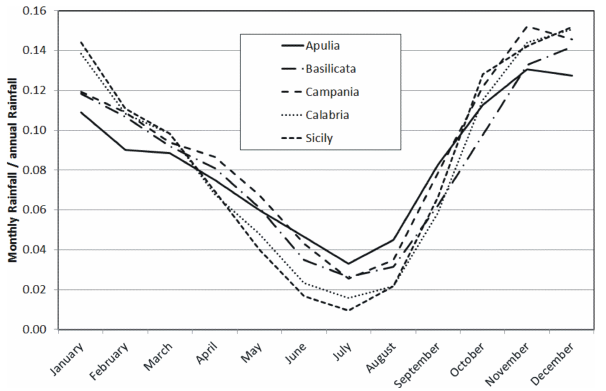
Fig. 3. Percentage ratios of the moving 10-year average rainfall to the average value of the decade 1994–2003 for the summer, the winter and the annual